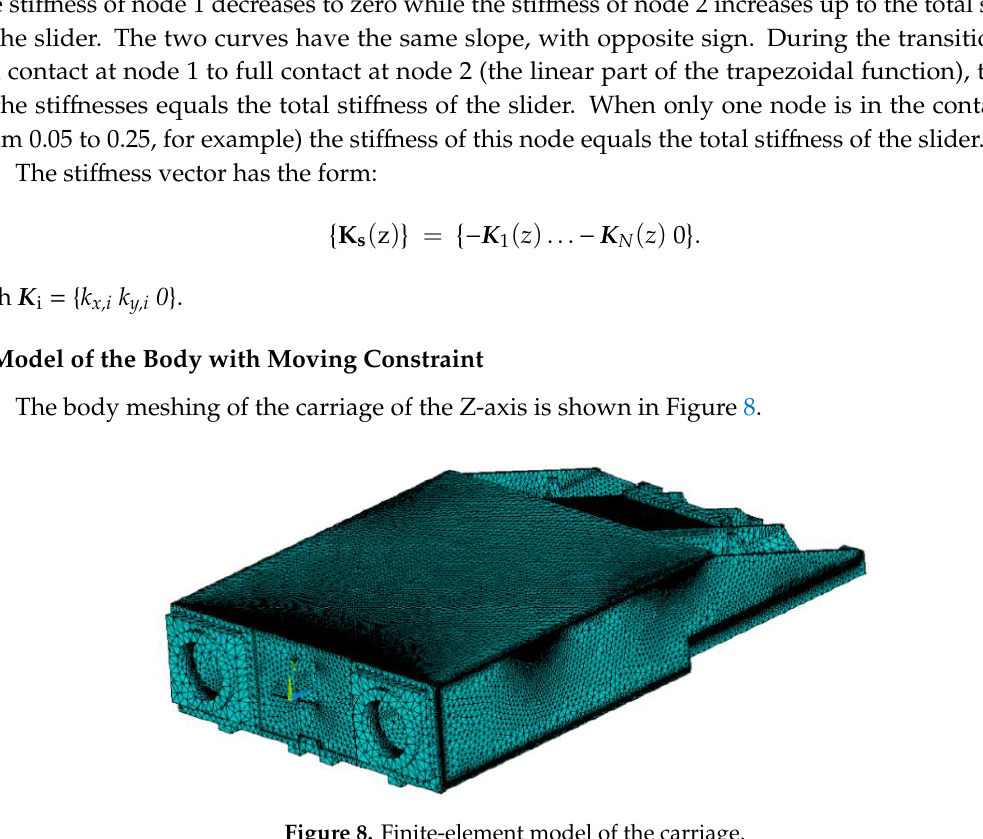
Figure 9. Simulink model of the system. From the position control system block, the position of the carriage along the Z-direction were derived. This information was the input of the stiffness vector block, of the magnetic force block and of the cutting force block, because, as seen before, the values of the corresponding variables are functions of the Z-position of the carriage. The cutting force inputs were, in addition, the time of the simulation, the amplitude of the force, the spindle speed and the position of the workpiece (in Figure 9, the constant act ). The sum of the forces was input for the state – space block. The displacement vector x was the output of the state – space block and it was multiplied by the stiffness vector for sliding- guide force evaluation.